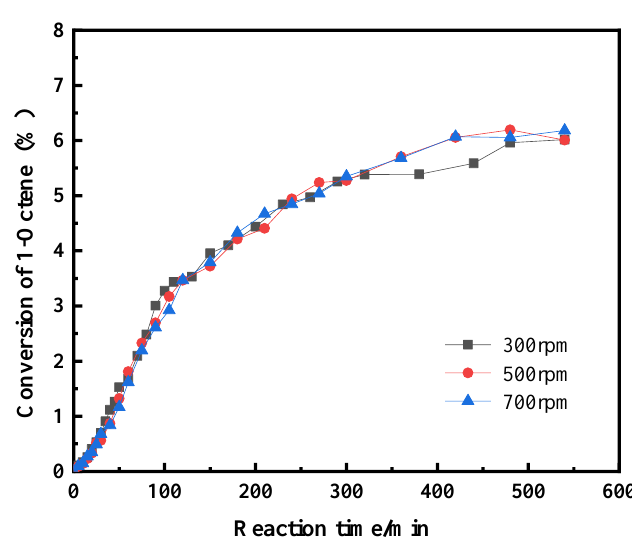
Figure 3. Effect of stirring speed on the reaction.